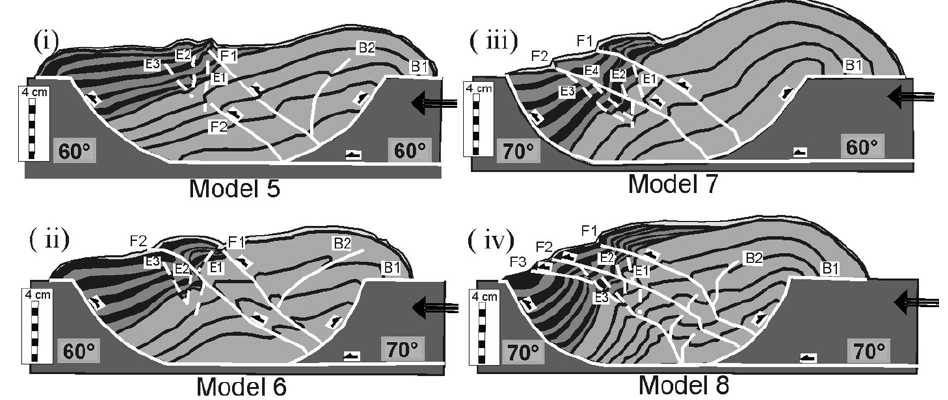
Fig. 10 – (i-iv) Line drawings of cross-sections cut through the central region of models 5 to 8: end results. E1-E4 are normal faults formed during extensional steps; F1-F3 are forethrusts, and B1 and B2, backthrusts. Dashed and continuous lines represent extensional and contractional structures,